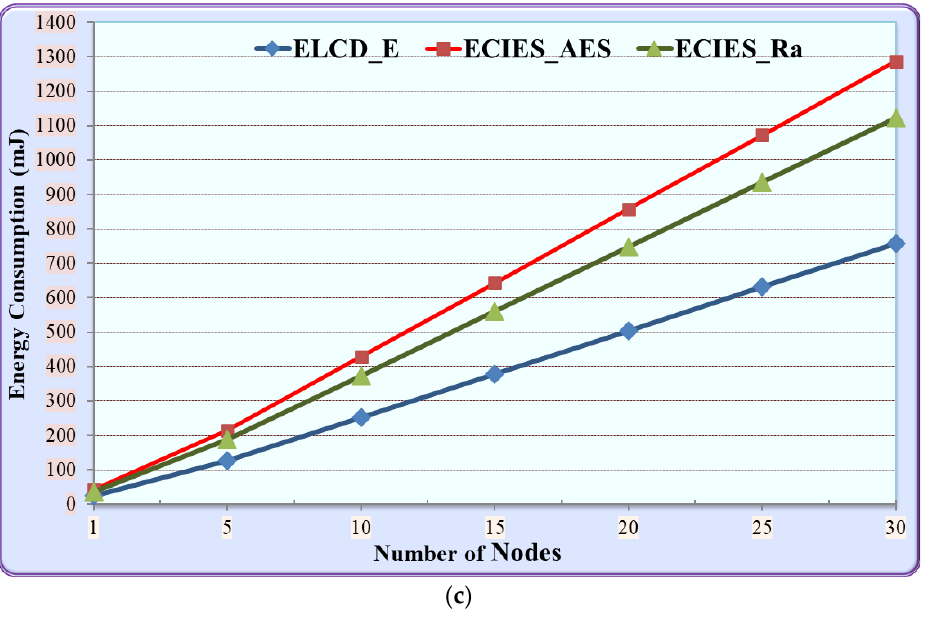
Figure 7. Comparison between ELCD encryption (ELCD_E) and baseline cryptographic algorithms on IoT ( a ) execution cost; ( b ) storage cost; ( c ) energy consumption.